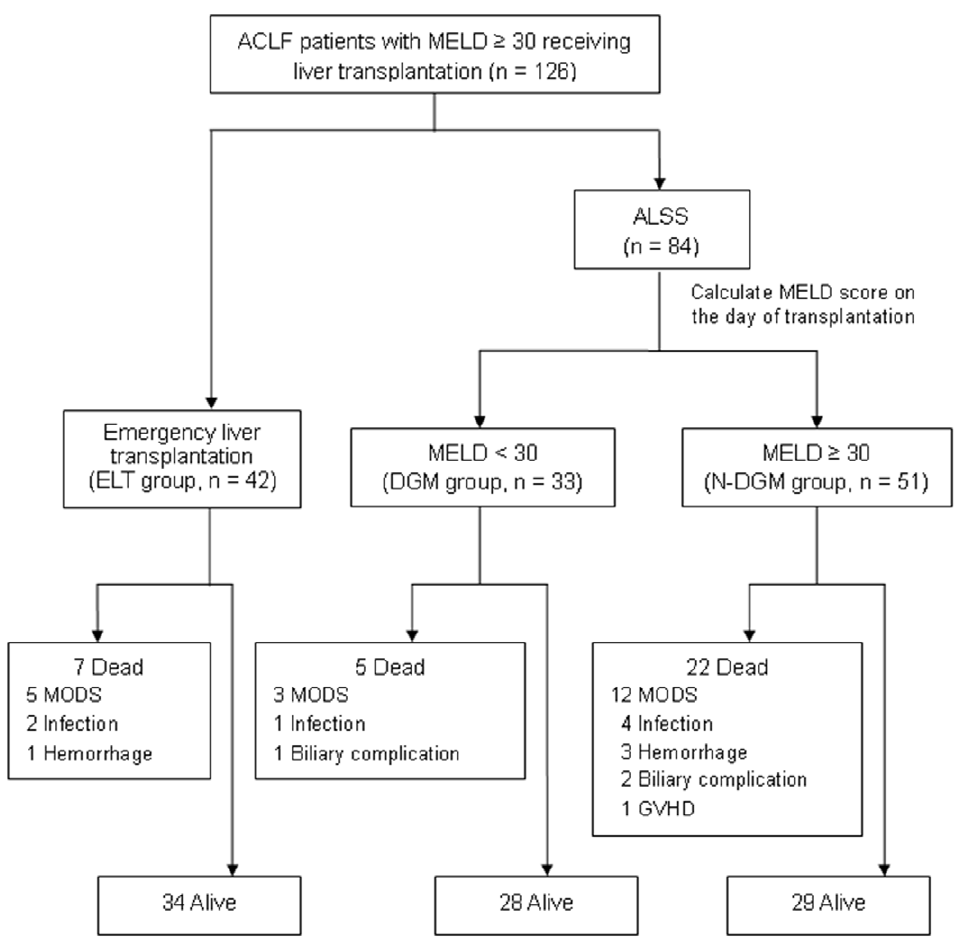
Figure 1. Outcomes of all 126 ACLF patients with pre-transplant MELD $ 30. ALSS, artificial liver support system; DGM, downgraded MELD; ELT, emergency liver transplantation; GVHD, graft versus host disease; MELD, model for end-stage liver disease; MODS, multi-organ dysfunction syndrome; N-DGM, non-downgraded MELD.